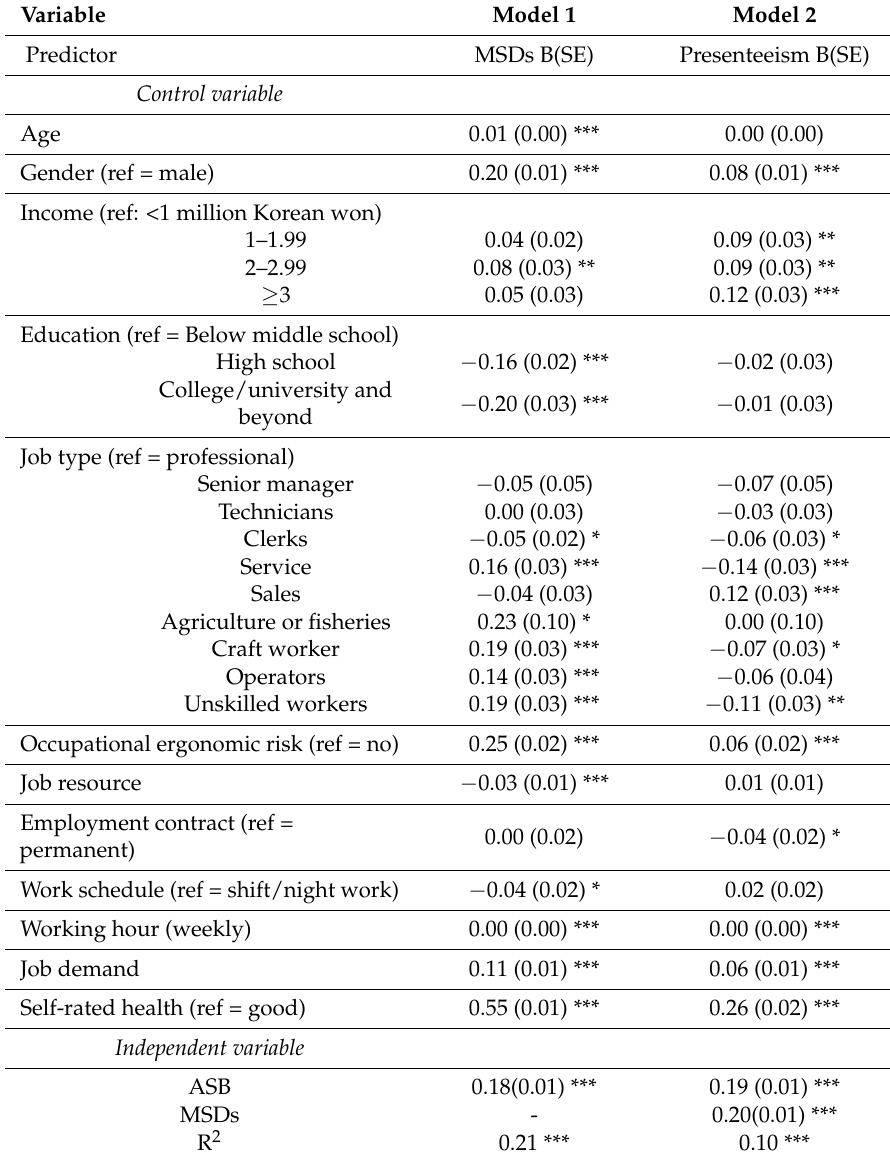
Table A1. Simple mediation